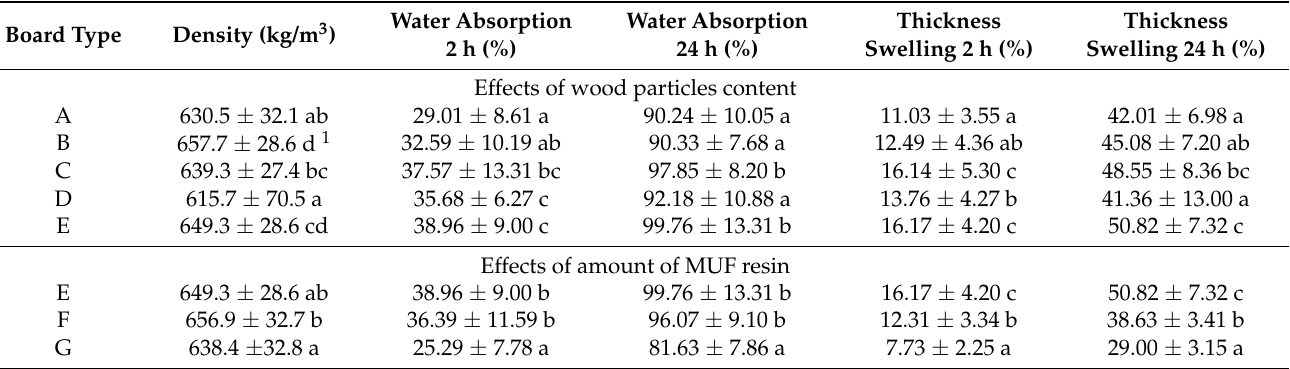
Table 3. Physical properties of particleboards.